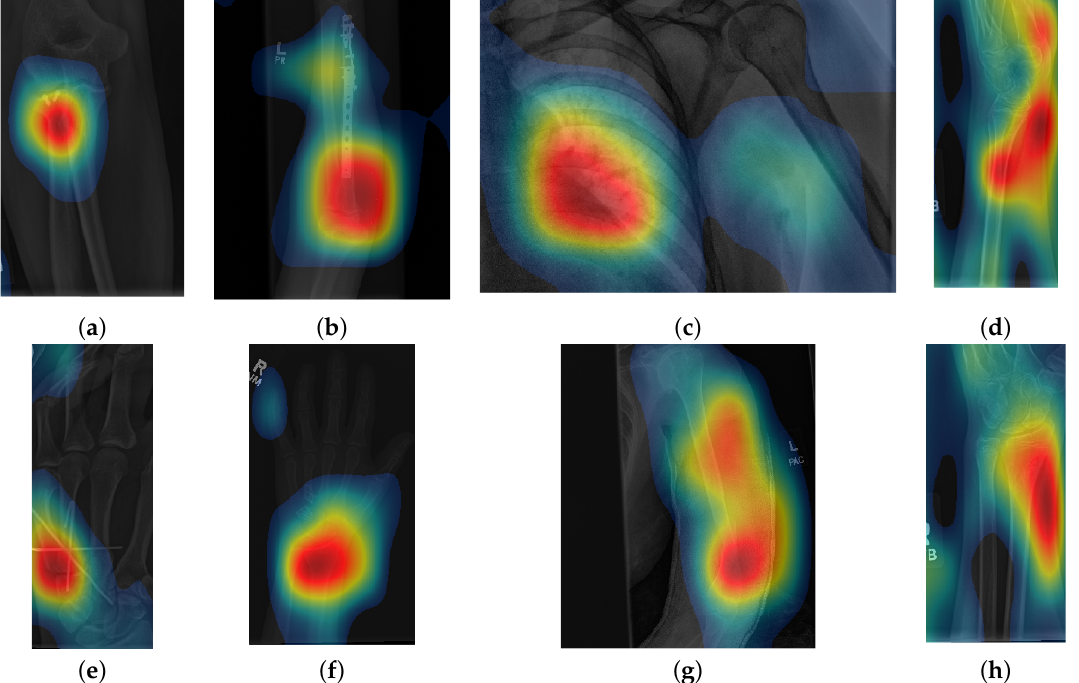
Figure 8. Illustration of activation maps overlaid over the eight radiographs with abnormalities of Figure 2 to indicate the regions of the image that activated a ResNet 50 architecture. ( a ) Elbow, ( b ) Forearm, ( c ) Shoulder, ( d ) Wrist (lateral view), ( d ) Lateral view of Wrist, ( e ) Finger, ( f ) Hand, ( g ) Humerus, (h) Wrist. The activation maps illustrate the location of the abnormalities, e.g., ( a , e ), but appears spread in other cases ( b , g ) where the abnormality is detected together with a neighbouring region. In other cases ( c ), the abnormality is not